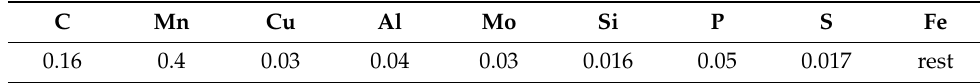
Figure 1. Flowchart of the research methodology. Table 1. The chemical composition of S235JR, wt.%.